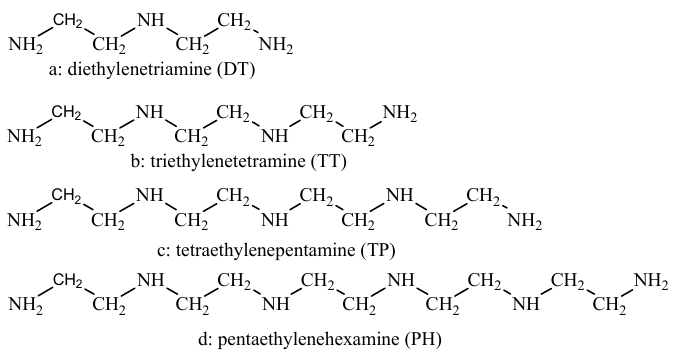
Figure 1. Chemical structures of ( a ) diethylenetriamine (DT); ( b ) triethylenetetramine (TT); ( c ) tetraethylenepentamine (TP); and ( d ) pentaethylenehexamine